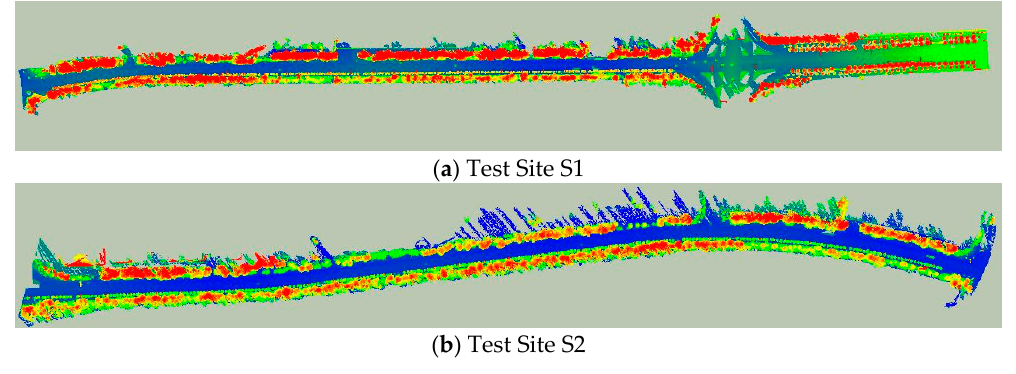
Figure 7. Overall view of the two test sites. Table 1. Description of the test sites.